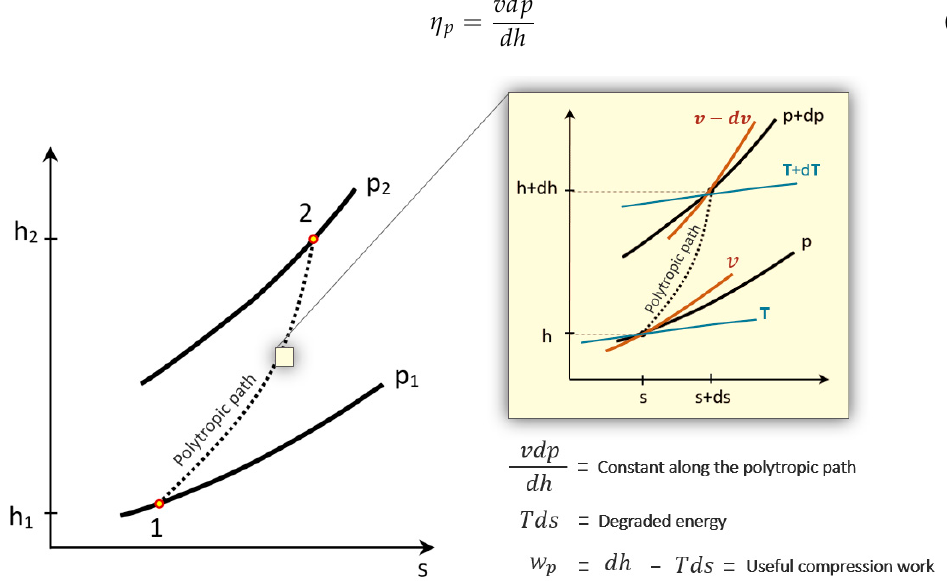
Figure 1. Polytropic compression path on the h-s Diagram.